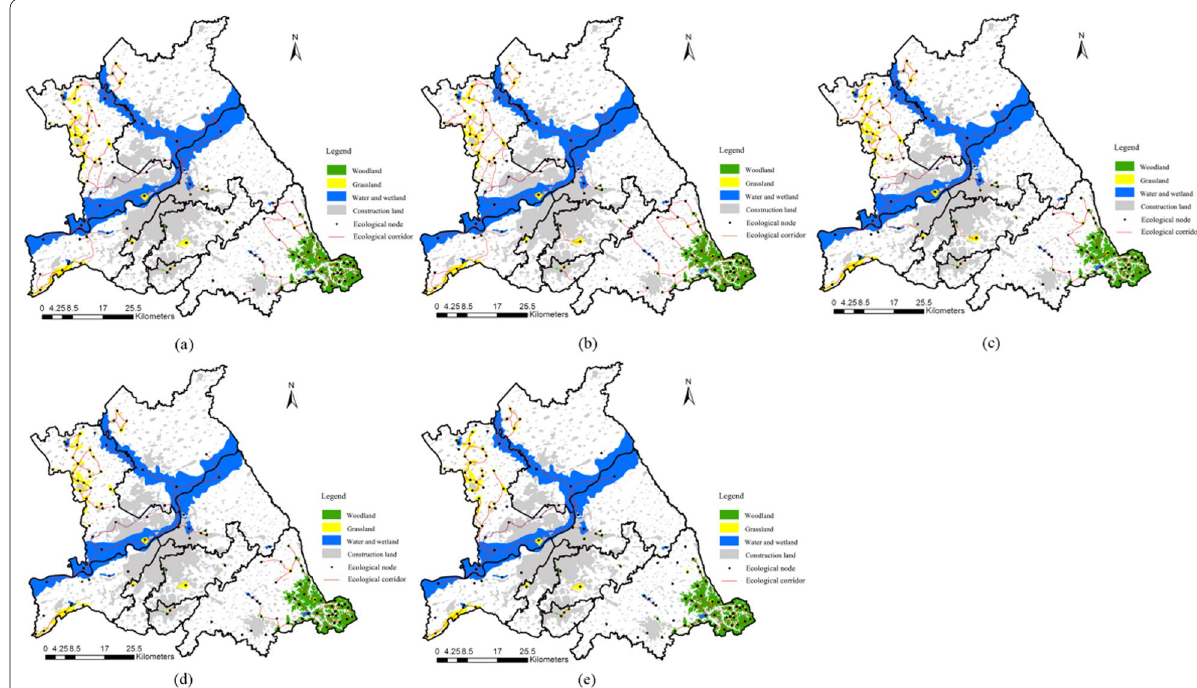
Fig. 5 GI network of the study area in multiple scenarios. a Current scenario, b 5% economic growth scenario, c 10% economic growth scenario, d 15% economic growth scenario, e 20% economic growth